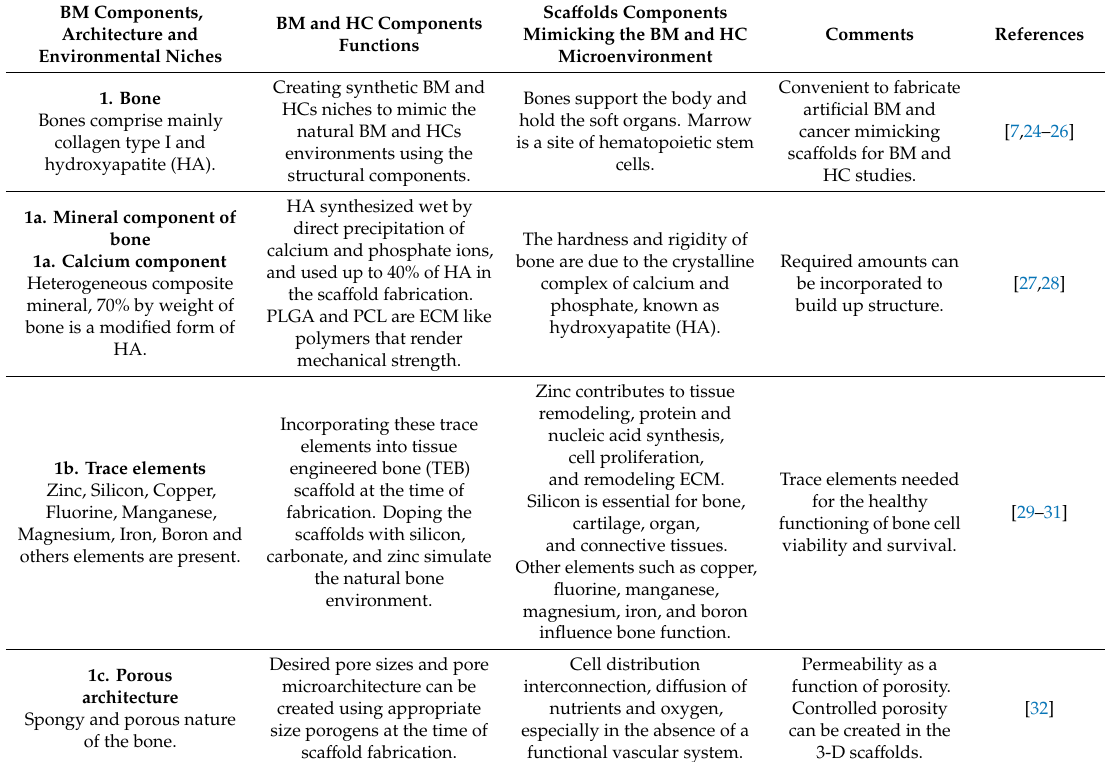
Table 1. Comparative constituents of natural BM and synthetic sca ff olds to reconstruct and replicate the BM microenvironment for transplantation and